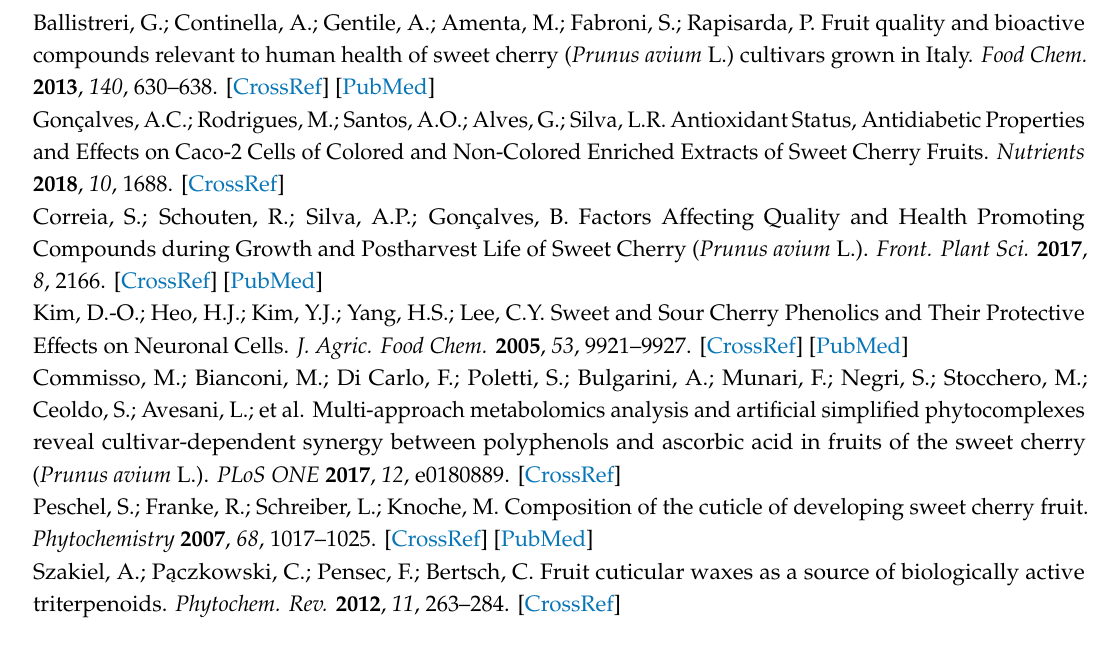
Supplementary Materials: The following are available online, Figure S1: Alignment of the sweet cherry and apple OSCs showing the conserved DCTAE (green highlight), M(W / Y)CY(C / S)R (cyan highlight), as well as the Q-X3-G-X-W motifs (yellow highlight)